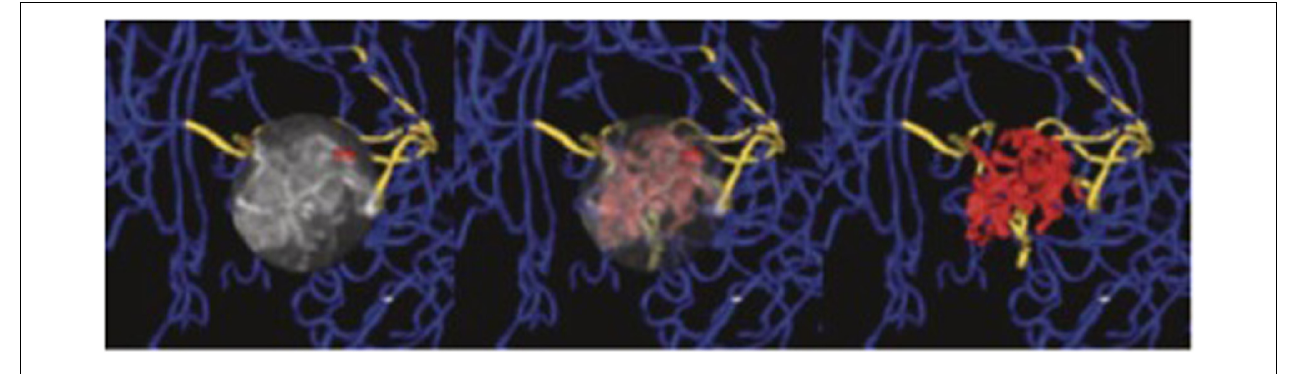
nidus, containing type II tortuosity vessels, is volume rendered at full opacity ( left ), at partial opacity ( center ), while vascular structures exclusively are shown at ( right ). Adapted from Bullitt and Gerig (2003), reproduced with